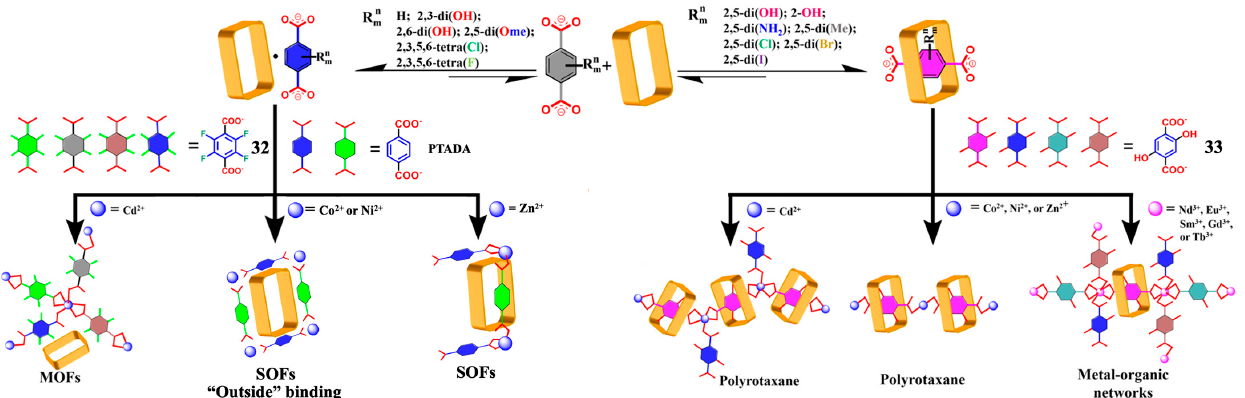
Figure 7. Schematic showing how the substituents defining a particular p -terephthalic acid dianion (PTADA) serve to stabilize various supramolecular constructs via interaction with the cationic macrocycle 1 . Modified with permission from a figure that first appeared in ref. [54]. Copyright 2020 American Chemical Society. Molecules 2021 , 26 , x FOR PEER REVIEW